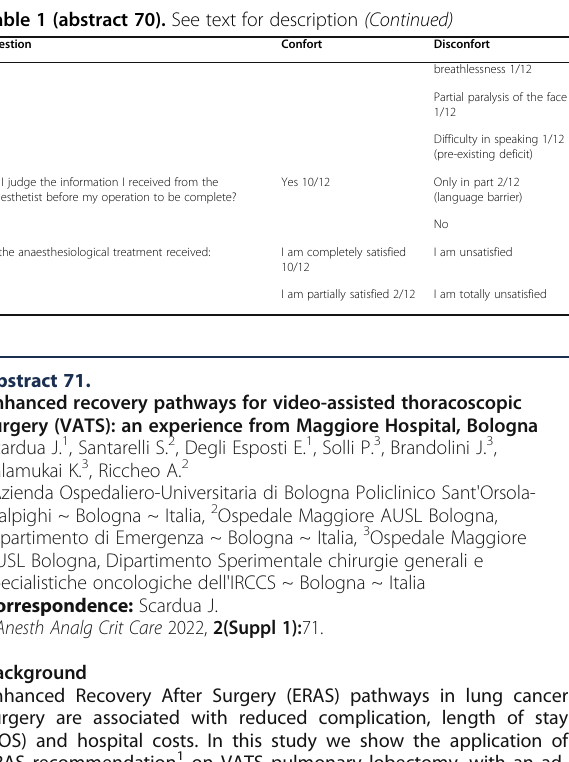
Table 1 (abstract 70). See text for description (Continued)